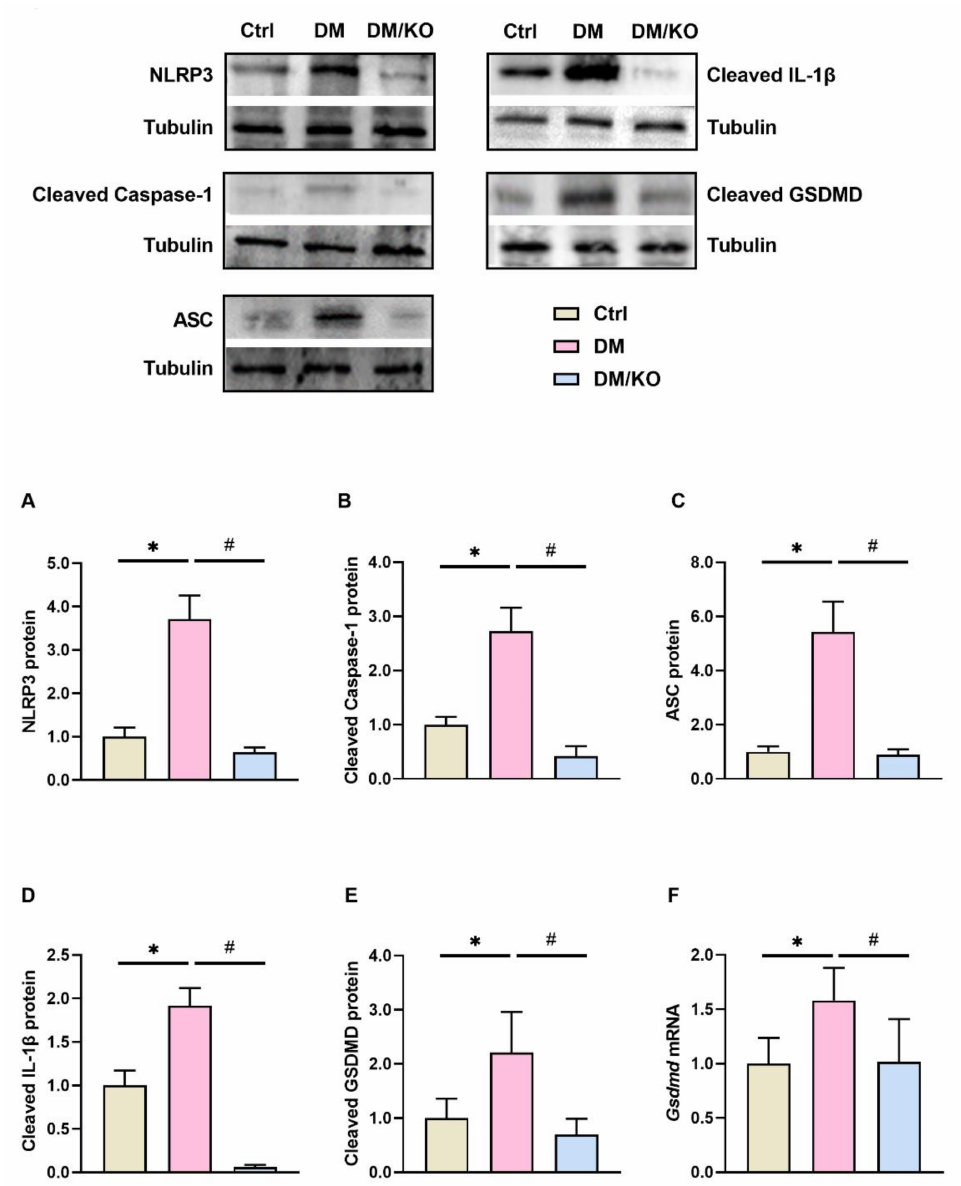
Figure 5. KO drastically inhibited NLRP3 inflammasome activation in the diabetic hearts. Cardiac protein expression of ( A ) NLRP3, ( B ) Cleaved caspase-1, ( C ) ASC, ( D ) Cleaved IL-1 β , ( E ) Cleaved GSDMD were determined by Western Blot. ( F ) Gsdmd mRNA levels. Tubulin and Rplp0 were used as endogenous controls for Western blot and qRT-PCR, respectively. The data were normalized to Ctrl and summarized as means ± SD. *, p < 0.05 vs. Ctrl; #, p < 0.05 vs. DM. Abbreviations: ASC, adaptor apoptosis-associated speck-like protein containing a caspase activation and recruitment domain; GSDMD, gasdermin D; NLRP3, Nod-like receptor family, pyrin domain containing 3. Other abbreviations are the same as Figures 1 and